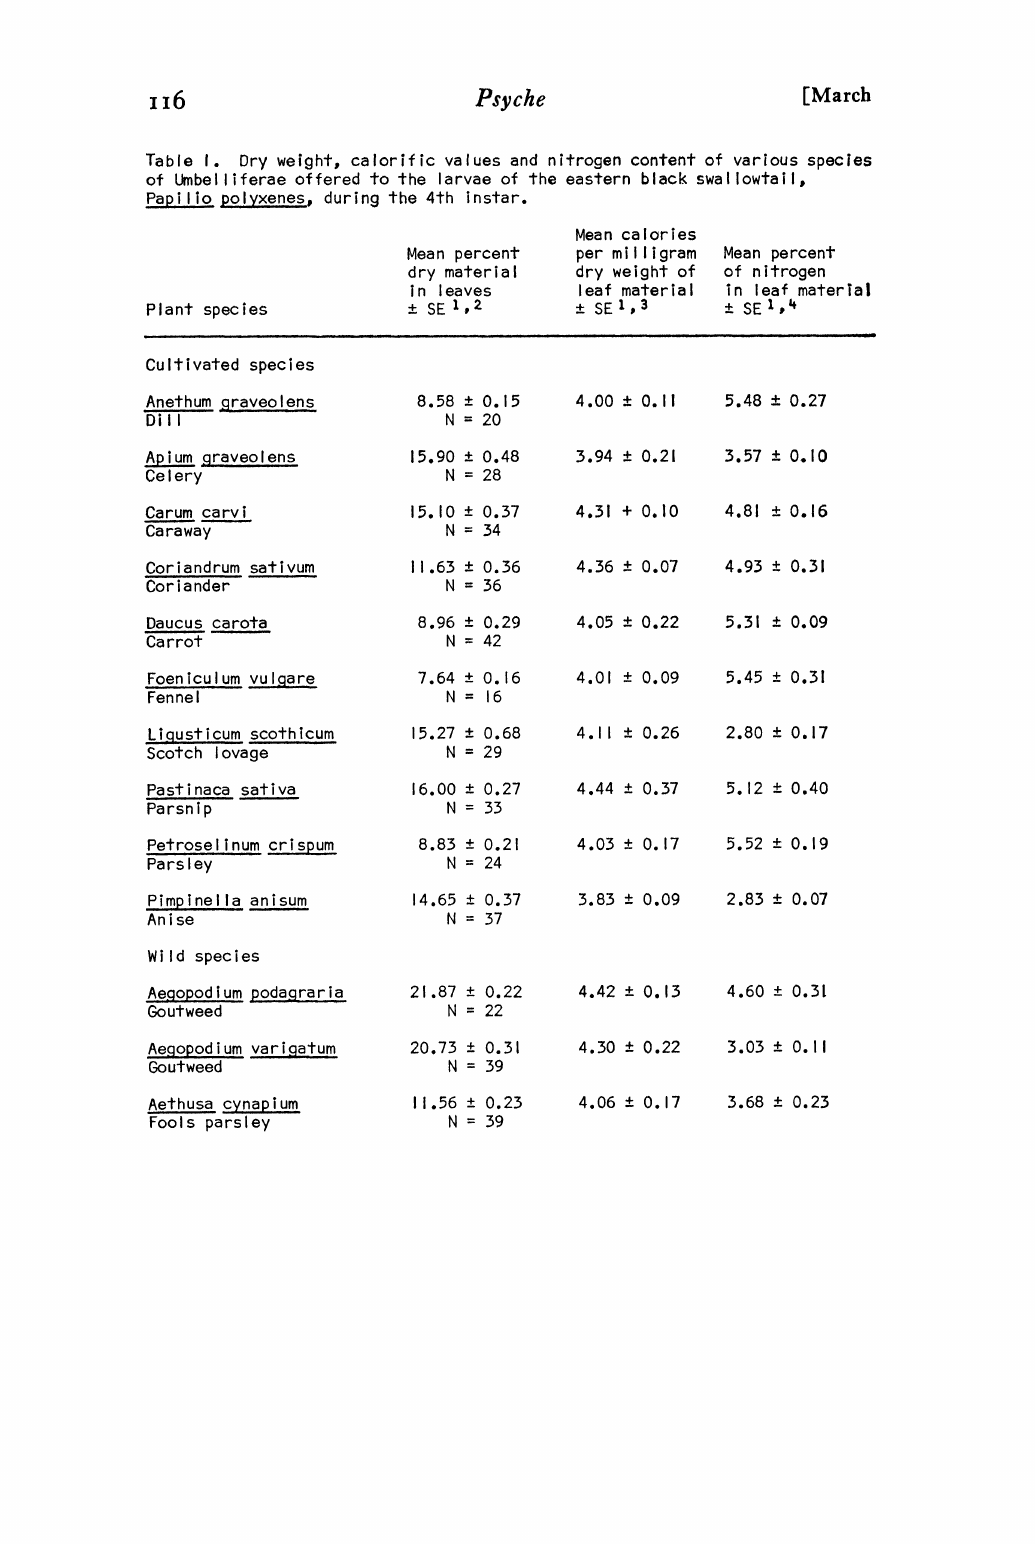
Table I. Dry weight, calorific values and nitrogen content of various species of Umbel liferae offered to the larvae of the eastern black swallowtail, Papiliopo!xenes, during the 4th